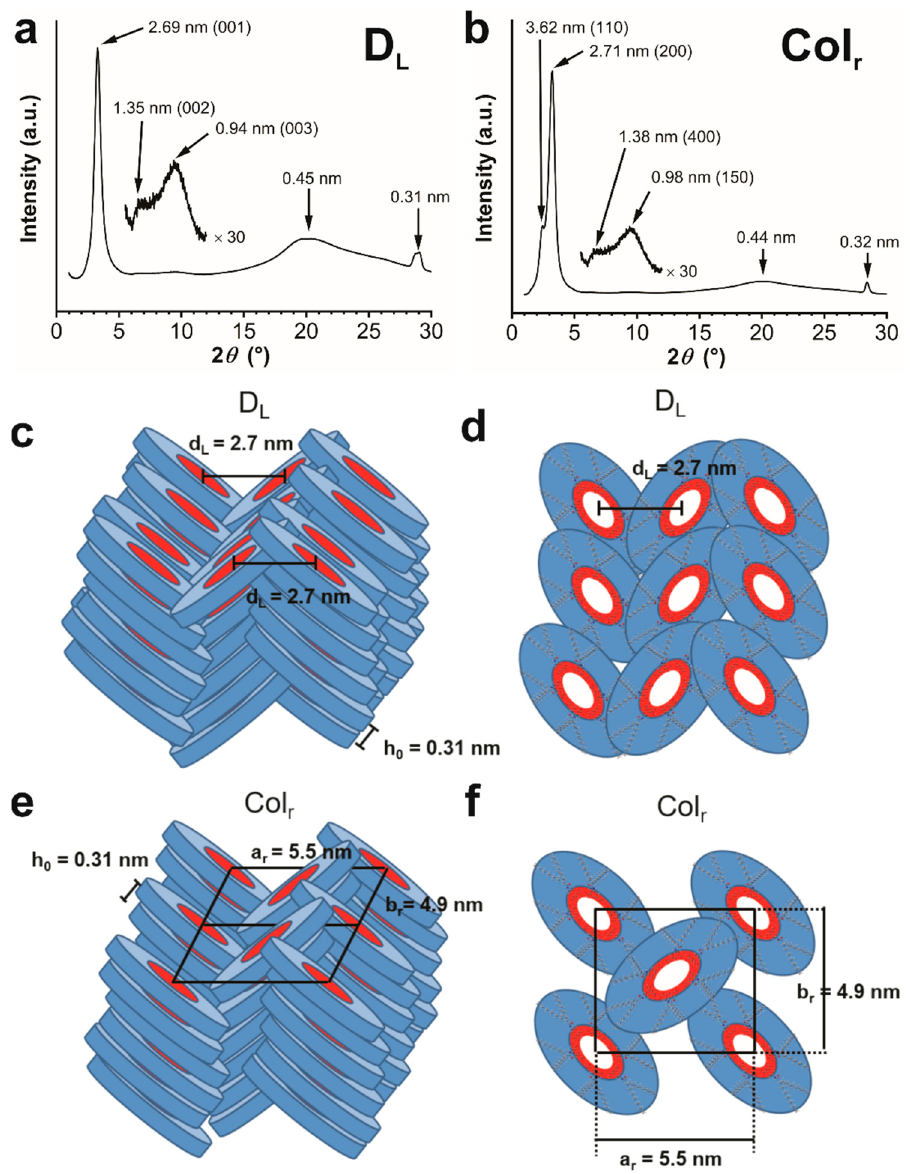
Figure 8. PXRD patterns of representative ( a ) lamello-columnar (D L ) and ( b ) rectangular columnar (Col r ) phases in aerogels of ISA24 randomly observed from freeze-dried cyclohexane organogels (2 wt%). Schematic representation of the proposed columnar phases of ISA24. ( c ) Side and ( d ) top views of the lamello-columnar phase (D L ). ( e ) Side and ( f ) top view of the rectangular columnar phase (Col r ). d L = repeating interlayer distance. h 0 = distance between discoids. a r , b r = Col r phase unit cell parameters.